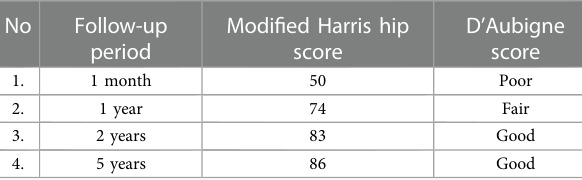
TABLE 1 Table showing the follow-up time period and consecutive improvement in modi fi ed Harris hip score and D ’ Aubigne